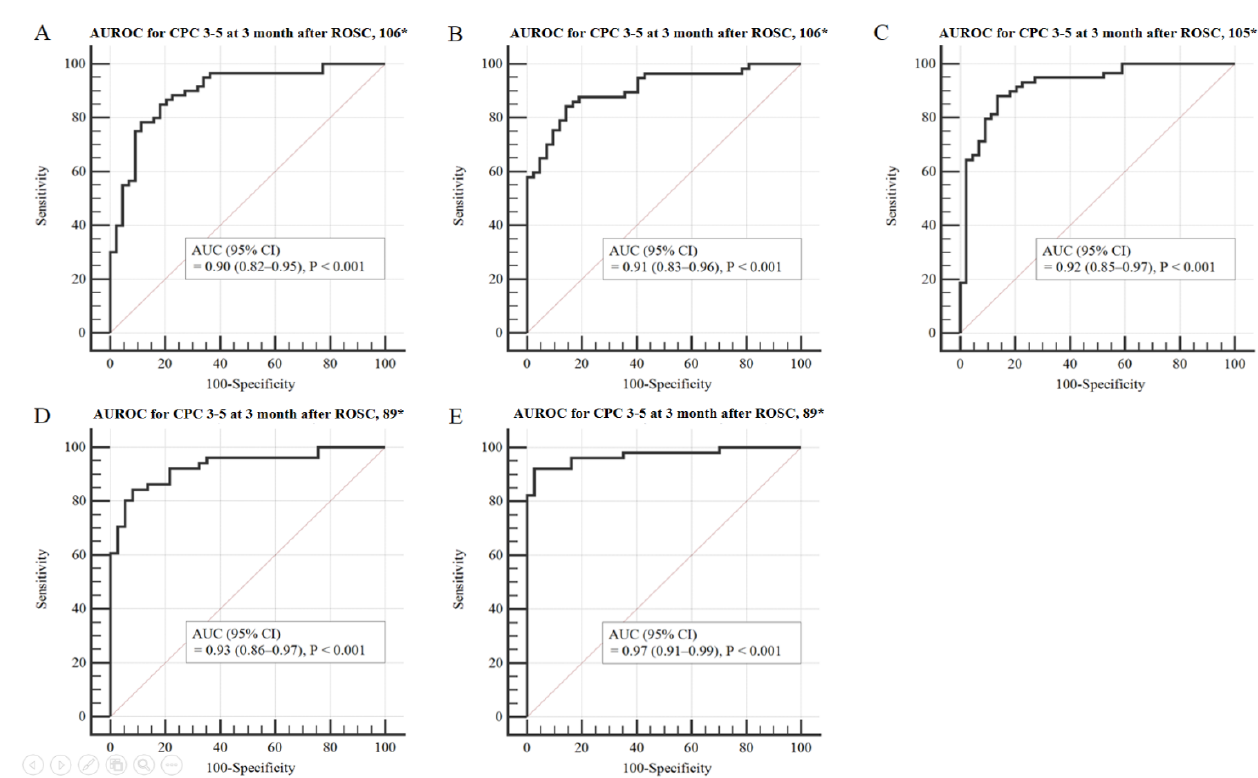
Figure 3. Area under the curve (AUC) to predict poor neurological outcome 3 months post-OHCA in the modified CAHP model. The ROC curve for the M-CAHP model is shown in panel ( A ); the ROC curve for the M-CAHP NSE model is shown in panel ( B ); the ROC curve for the M-CAHP GWR model is shown in panel ( C ); the ROC curve for the M-CAHP PV400 model is shown in panel ( D ); the ROC curve for the M-CAHP HSI model is shown in panel ( E ). Abbreviations: CAHP, cardiac arrest hospital prognosis; ROC, receiver operating characteristics; NSE, neuron-specific enolase; GWR, grey/white matter ratio; PV, percentage of voxel; HSI, high signal intensity; CI, confidence interval. * Number of patients included in the analysis.